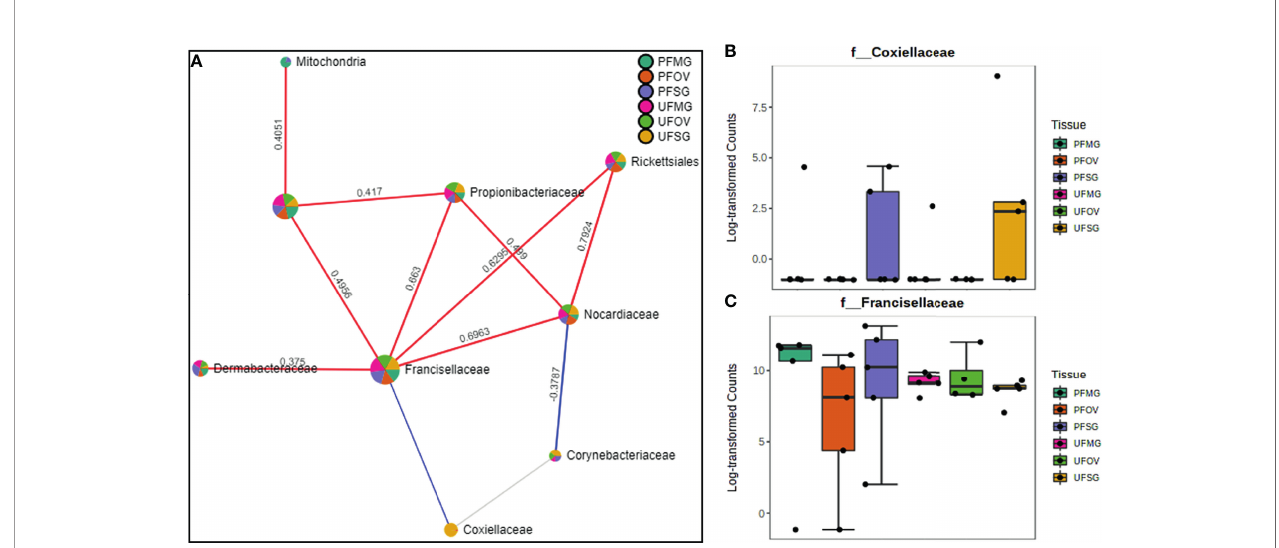
FIGURE 8 | Correlation network analysis in different tissues of Amblyomma americanum ticks from Illinois. Correlation network generated using the SparCC algorithm. Correlation network with nodes representing taxa at the family level and edges representing correlations between taxa pairs (A) and representative boxplots showing enriched abundance of Coxiellaceae (B) and Francisellaceae (C) across all samples.